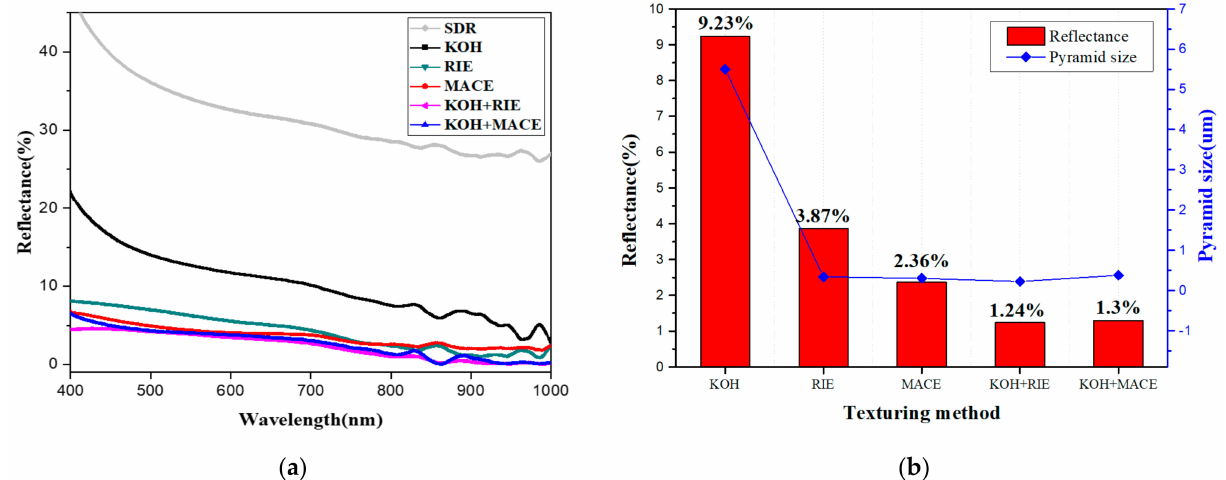
Figure 14. Reflectance characteristics and pyramid size according to various etching process methods: ( a ) reflectance with etching process methods in the wavelength range of 400~1000 nm and ( b ) a comparison of reflectance when different etching process methods were utilized.